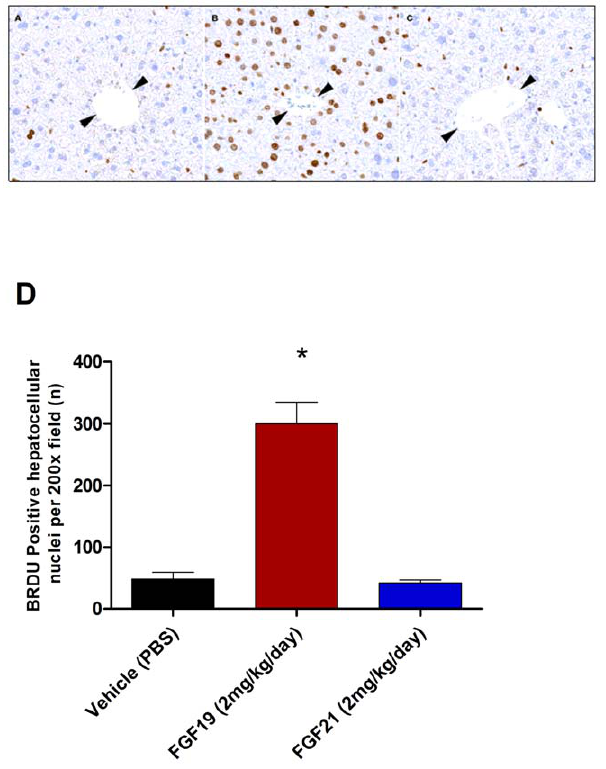
Figure 4. FGF19 treatment leads to hepatocellular prolifera- tion. All mice received a constant infusion of BRDU during the 7 days of treatment. At the end of treatment samples of liver were harvested, preserved in formalin, processed routinely, and embedded in paraffin. Tissue sections were cut, immunolabeled for BRDU, and counterstained with hematoxylin. Representative sections are shown here from mice receiving injections of phosphate buffered saline (PBS; A), FGF19 (B), or FGF21 (C). The average number of BRDU-positive nuclei per 200 6 microscopic field is shown. Mice administered FGF19 had a statistically significant increase (*=p , 0.0001) in the numbers of hepatocytes with BRDU-positive nuclei when compared to mice administered PBS (D). In contrast to FGF19, FGF21 did not induce hepatocellular proliferation. The arrowheads indicate the location of the centrilobular veins.